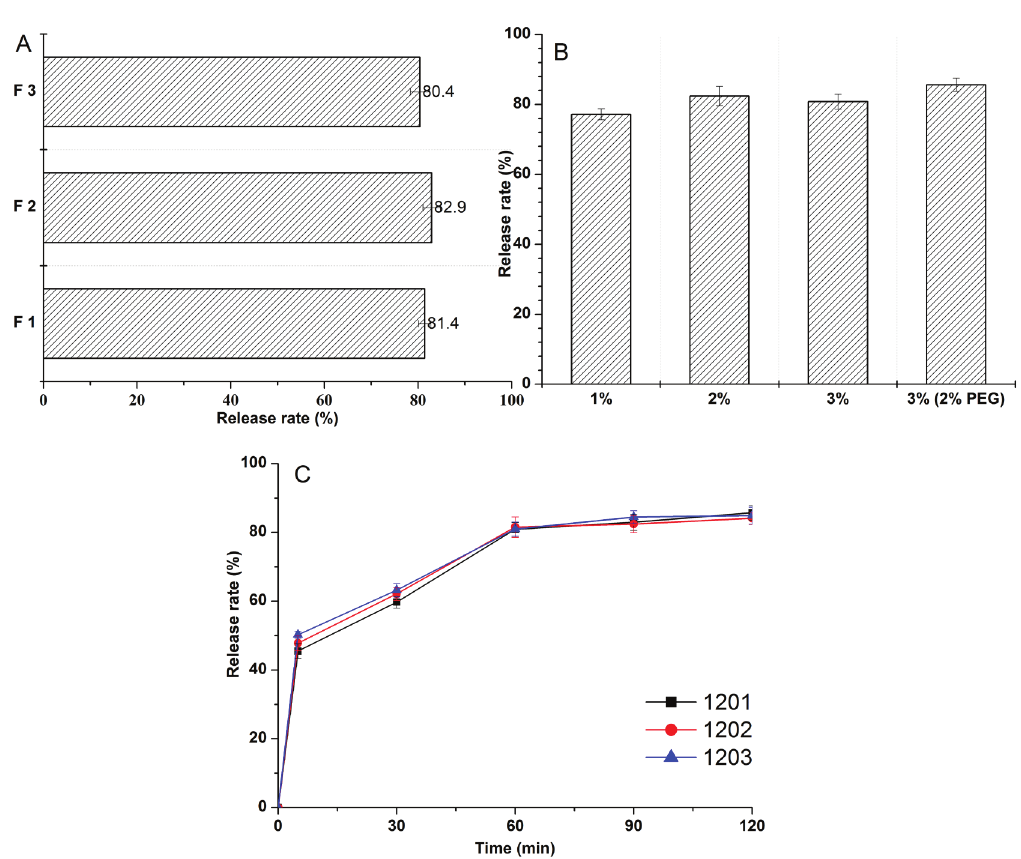
FIGURE 2 - The effect on dissolution rate of the ratio of RTFA, MCC and PEG (A) and the concentration of HPMC (B); and the release profile of RTFA from the core drug-loaded granules in a simulated colonic fluid (pH 7.4) containing rat caecal contents